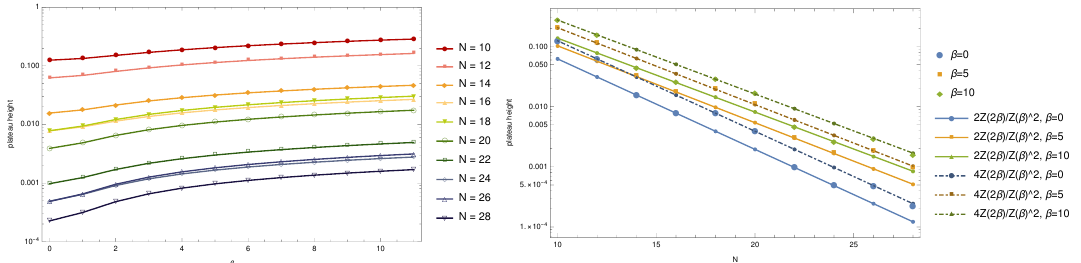
Figure 9 . The plateau height g p for supersymmetric SYK model. In the left (cid:12)gure we choose several temperatures and (cid:12)x N in each curve, while in the right we (cid:12)x (cid:12) and evaluate g p ( N